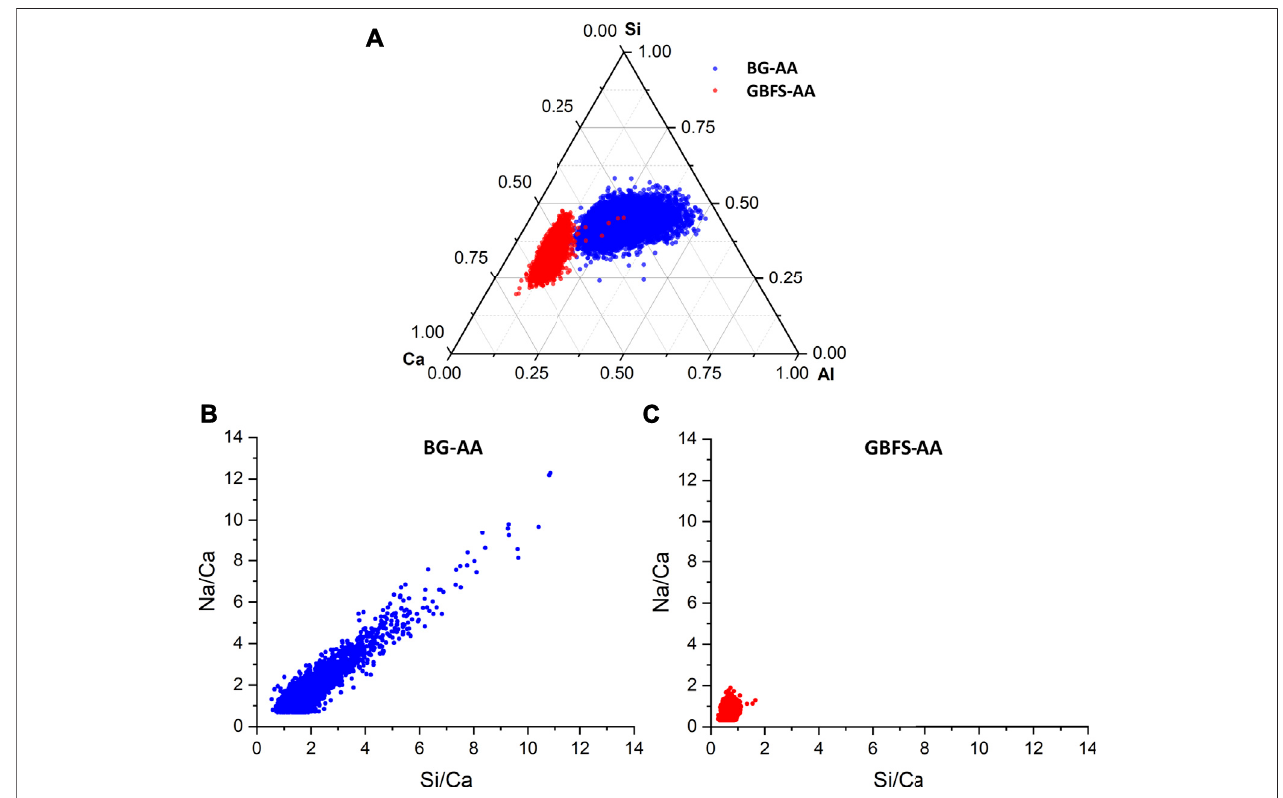
FIGURE 7 | Atomic plots of hydrates in AAMs from BG compared to that of GBFS.